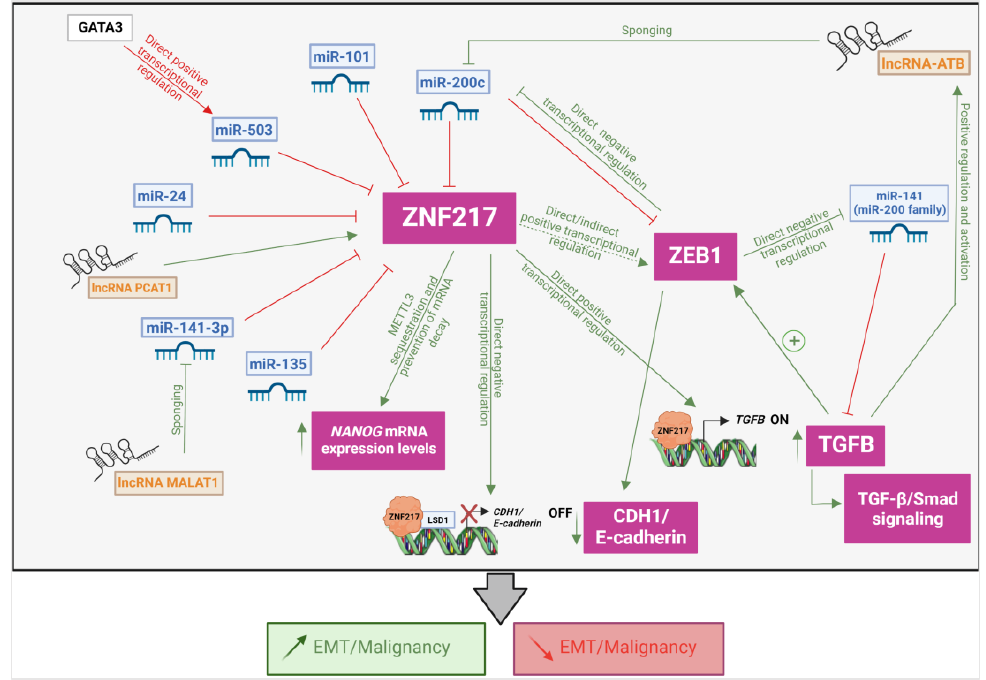
Figure 3. Intricate interactions between ZNF217 and ncRNAs regulate EMT and malignancy. Regu- lating events (miRNA binding to ZNF217 and other drivers of EMT, lncRNA sponging of miRNA, and transcriptional regulation) leading to activation of EMT and an increase in malignancy (arrows in red) or leading to inhibition of EMT and a decrease in malignancy (arrows in green). Arrows with bars refer to an inhibition. Created with Biorender.com.